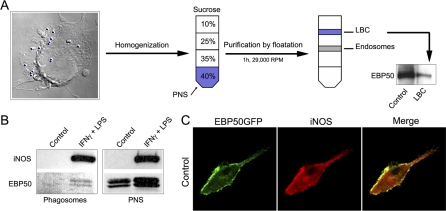
EBP50 Copurifies with Latex Bead Phagosomes and Colocalizes with iNOS(A) Latex bead phagosome preparation according to the previously published procedures [27]. Macrophages were infected with latex beads for 1 h, homogenized, and latex bead compartments isolated by floatation in a sucrose gradient. Western blot of 50 μg of protein per lane developed with EBP50 antibody. PNS, post-nuclear supernatant. Control, PNS; LBC, latex bead compartment.(B) iNOS and EBP50 are present on isolated magnetic bead phagosomes. RAW 264.7 macrophages were untreated (control) or activated for 16 h with IFN-γ and LPS prior to phagocytosis. Magnetic beads were phagocytosed for 1 h, and post-nuclear-supernatant and phagosomes were prepared and analyzed by western blot.(C) Macrophages were transfected with EBP50-GFP (green) and stimulated with IFN-γ and LPS for 16 h. Cells were fixed, stained for endogenous iNOS (red), and examined by confocal microscopy.